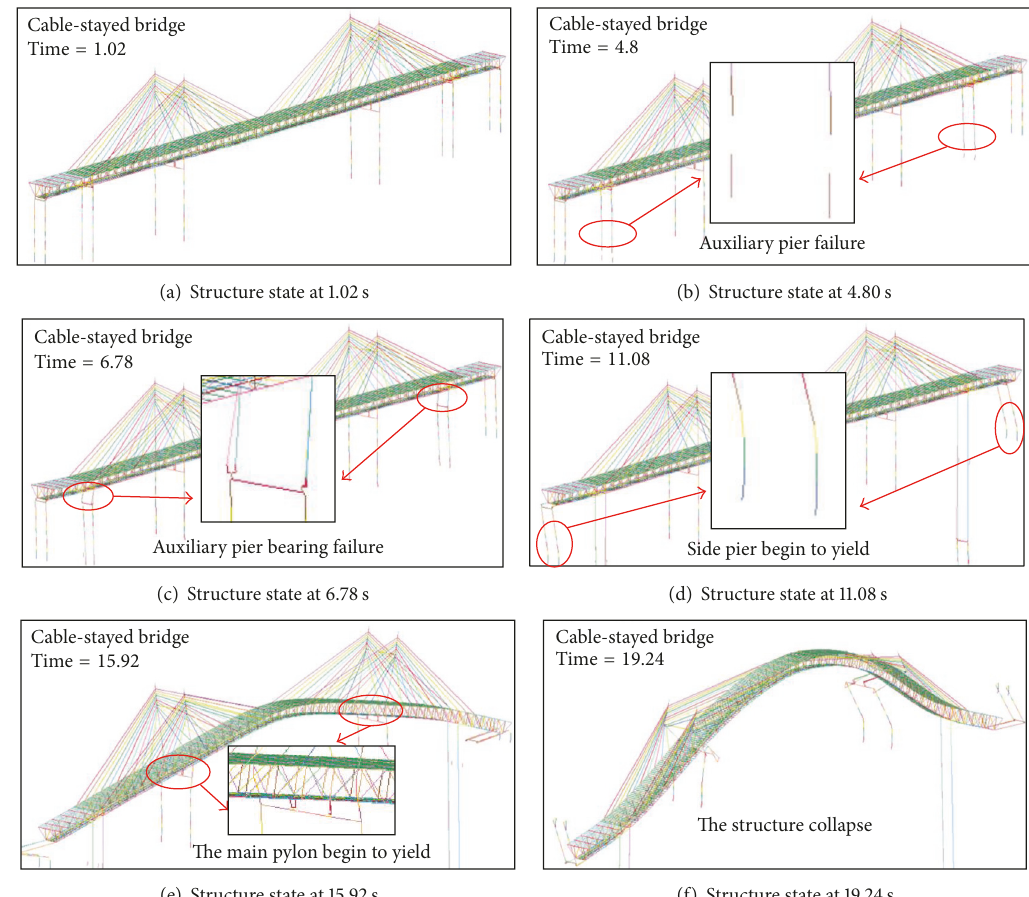
Figure 15: Collapse failure process under RSN13-H1 seismic